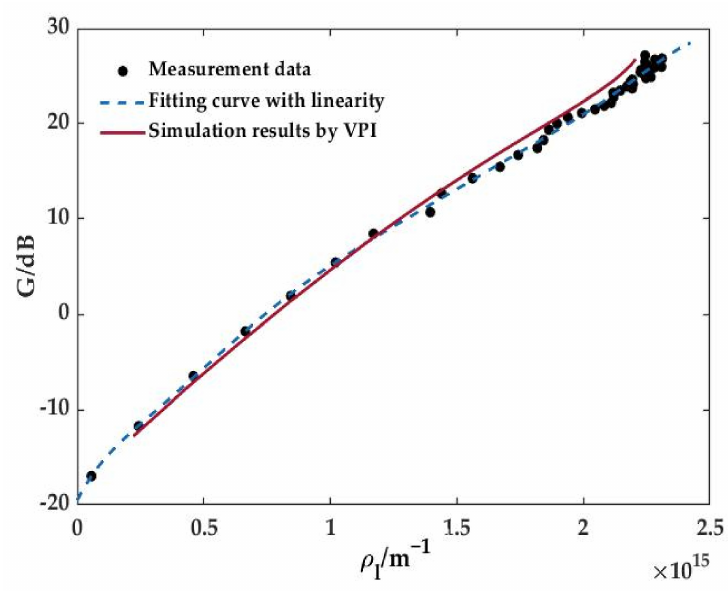
Figure 3. The gain curve of the LP01-mode signal with the population inversion